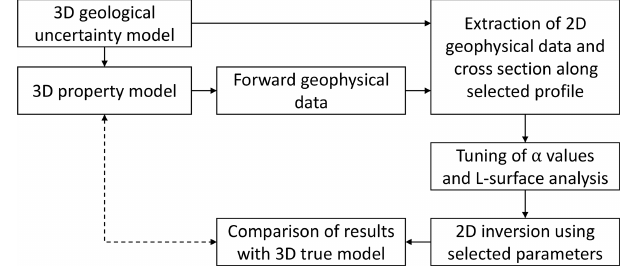
Figure 5. Summary of experimental protocol for synthetic study and testing of different functionalities of Tomofast-x.